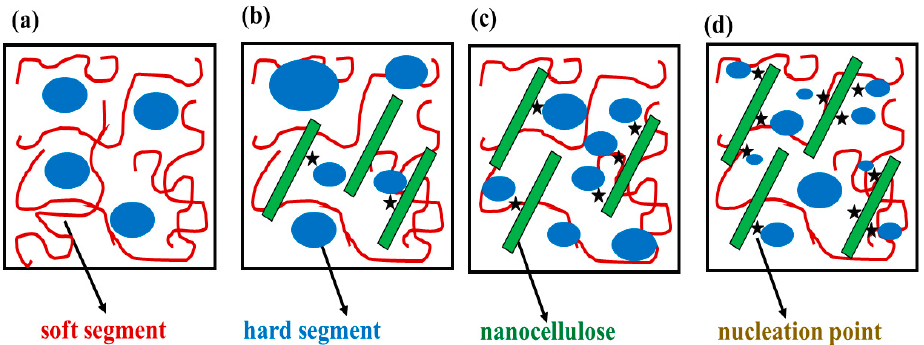
Figure 9. Schematic diagram representing nanocellulose induced nucleation point to the formation of the microstructure of the hard domain in TPU. Adapted from [159]. TPU ( a ), TPU/nanocellulose ( b – d ).